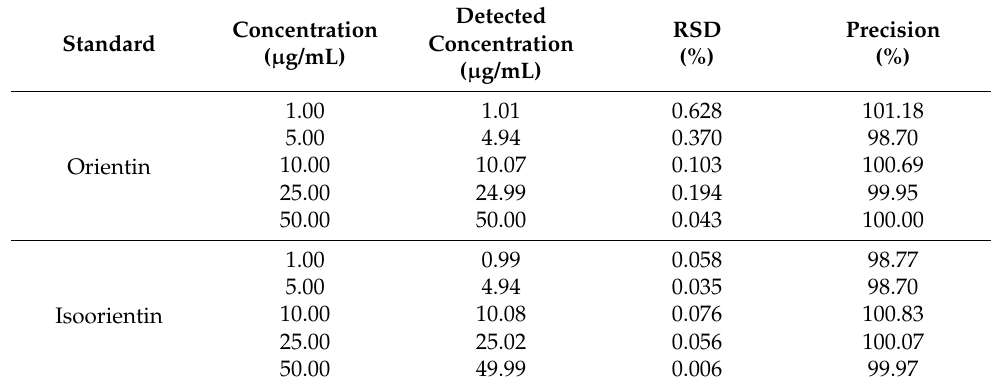
Table 2. Inter-day precision for orientin and isoorientin using the HPLC–PDA method ( n = 3).